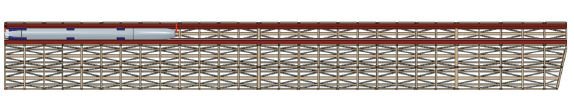
Figure 3: Launching platform and missile.